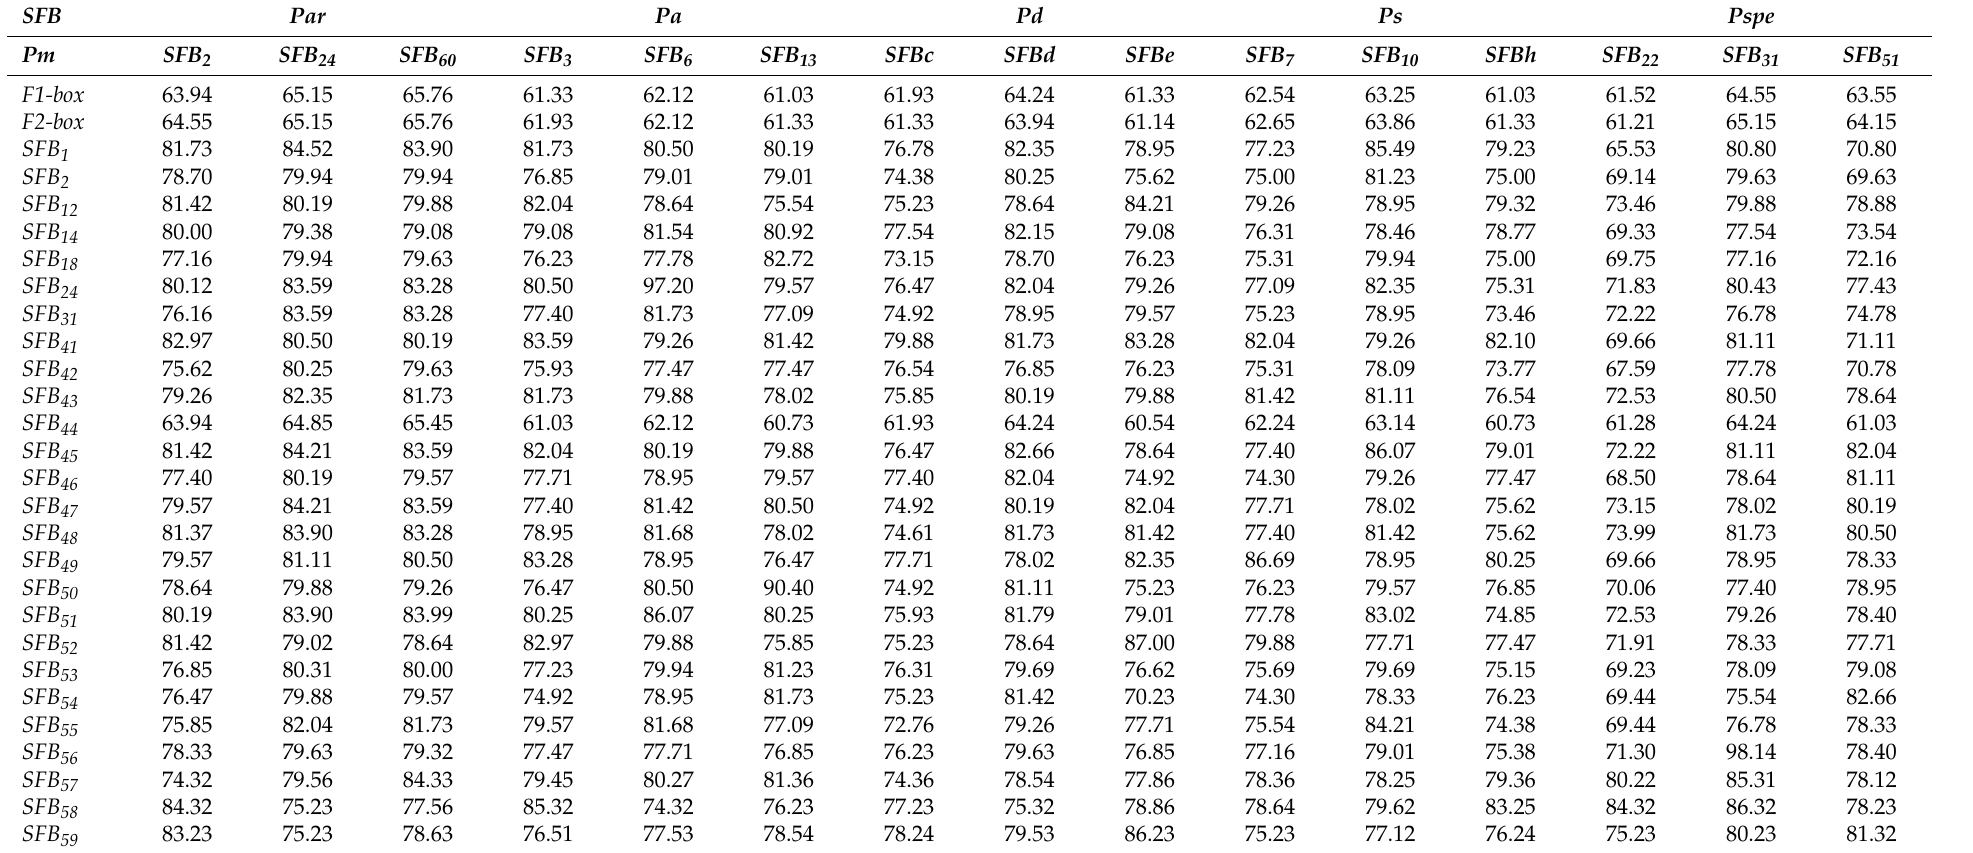
Table 3. Homologies (%) of deduced amino acid sequences of PmSFB alleles with other Prunus